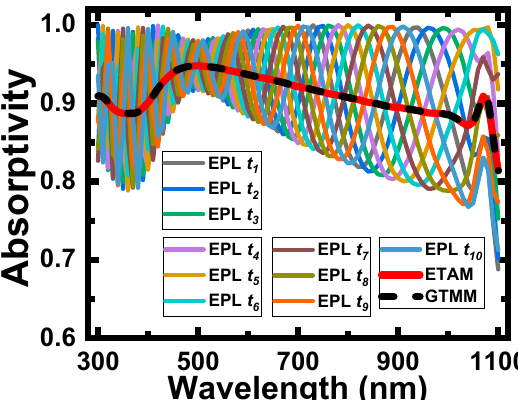
Figure 5. Calculation results of the absorptivity spectra A ( λ , t b ) depending on 10 di ff erent equispaced phase thicknesses of t 1 , t 2 , ··· and t 10 . The ETAM-applied absorptivity spectrum A ETAM ( λ ) was obtained by averaging 10 coherent calculation results over the equispaced phase thickness. The absorptivity spectrum calculated by another analytical model of the generalized transfer matrix method (GTMM) shows a good agreement with that obtained based on the ETAM, which verifies the validity of the calculation results obtained using the ETAM.